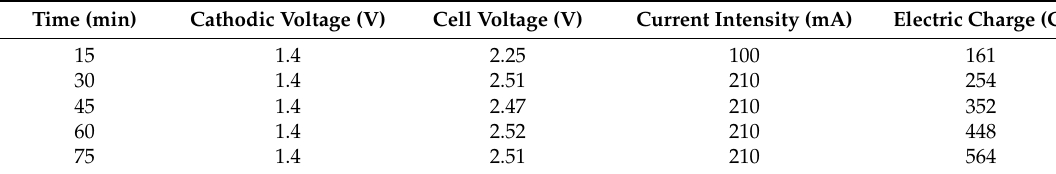
Table 8. Experimental gold electrowinning parameters.